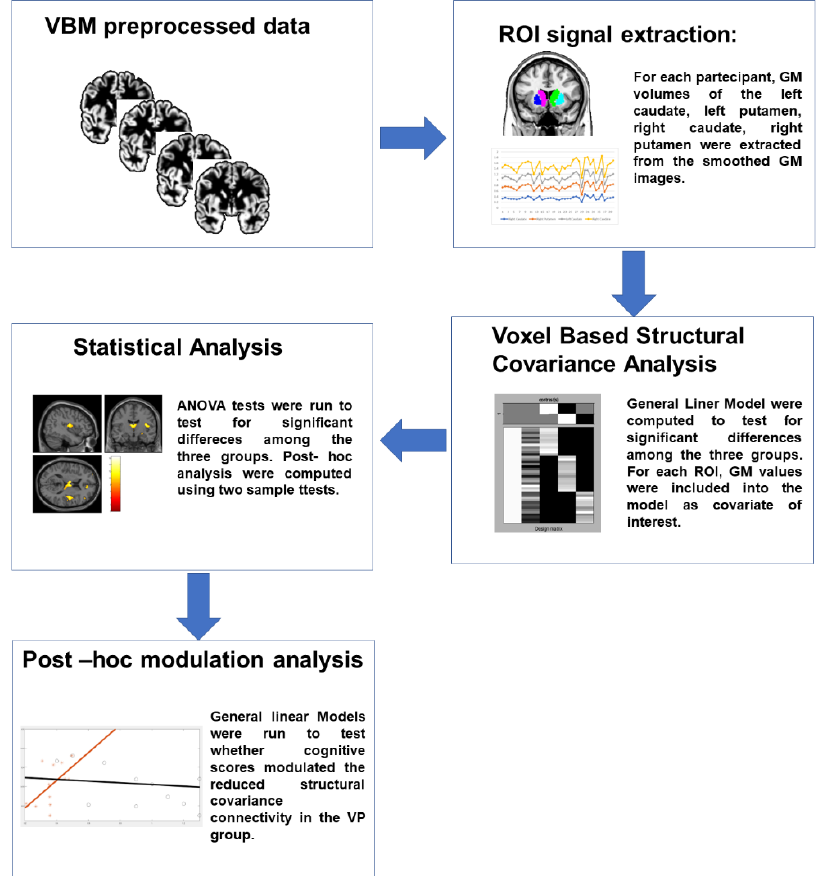
Figure 1. Workflow of the analyses. Subject-specific T1-weighted images were preprocessed using CAT12 toolbox and gray matter (GM) maps were generated. GM values of specific ROIs were extracted and entered as covariate of interest in separate GLMs to test for differences in the structural covariance connectivity among the three groups. T-contrasts were then used to compare each couple of groups. Finally, to test whether the reduced structural covariance connectivity in the VP group was explained by the lower scores in cognitive domains, a post hoc modulation analysis was run.